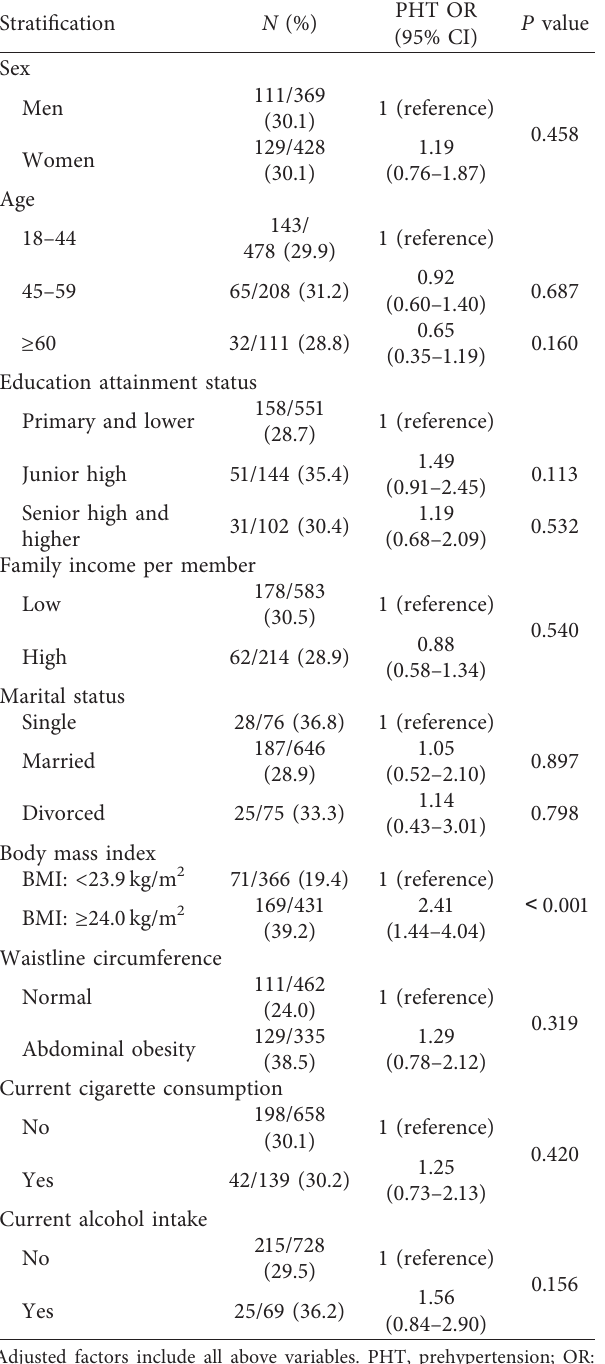
Table 5: Factors associated with hypertension from study pop- ulation by multiple logistic